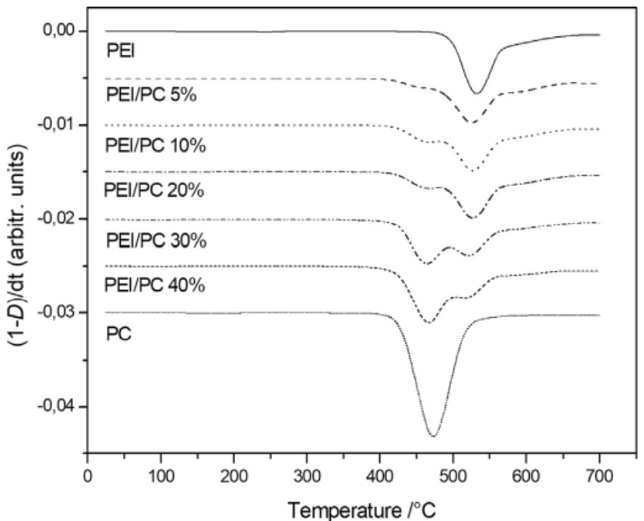
Figure 3. DTG curves in static air atmosphere for PEI, PC, and the various blends. Reprinted from [21] with permission from Elsevier.